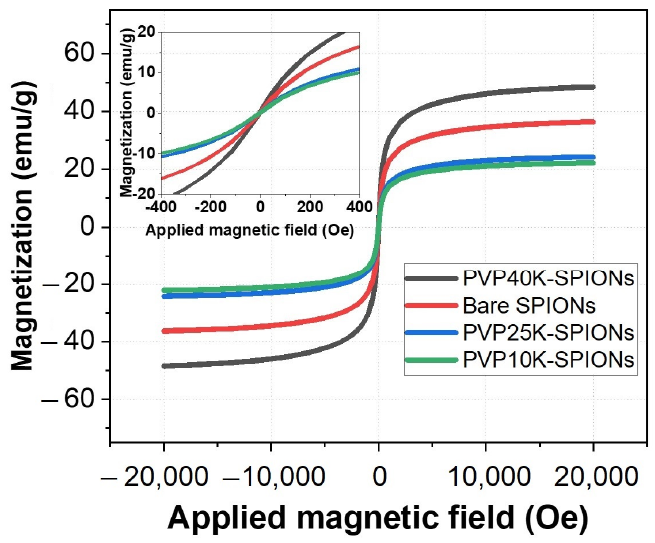
Figure 5. Magnetization curves at room temperature for bare SPIONs and SPIONs coated with different molecular weight of PVP. The inset represents the magnetic behavior of all investigated samples at low applied magnetic field.